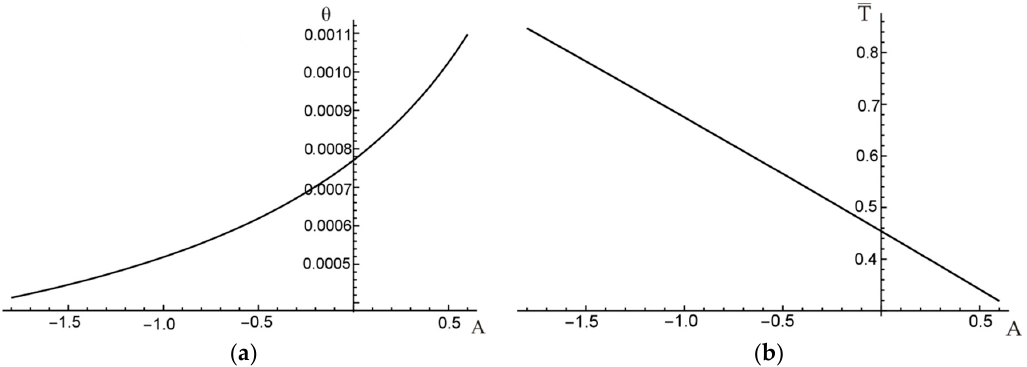
Figure 10. ( a ) Unit angle of twist and ( b ) dimensionless external torque versus square function coefficient A .